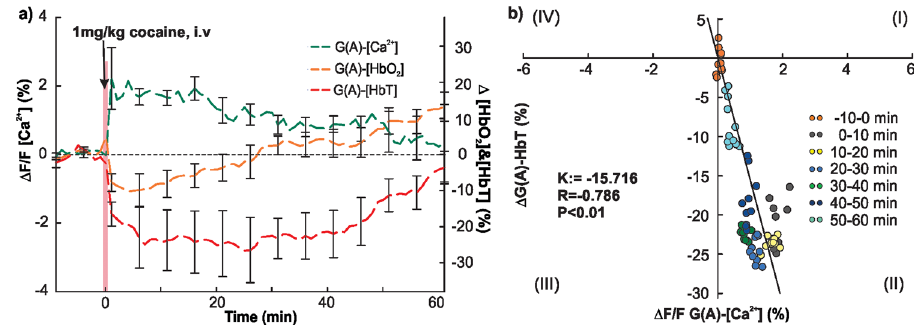
(green), Ca 2 þ - G ð A Þ